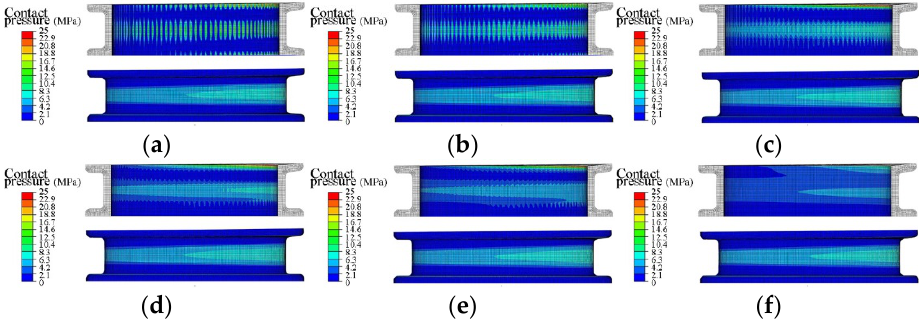
Figure 13. Contact pressure distribution of C-ring under different working distances. ( a ) 0 km; ( b ) 1.8 km; ( c ) 3.6 km; ( d ) 7.2 km; ( e ) 14.4 km; ( f ) 28.8 km.